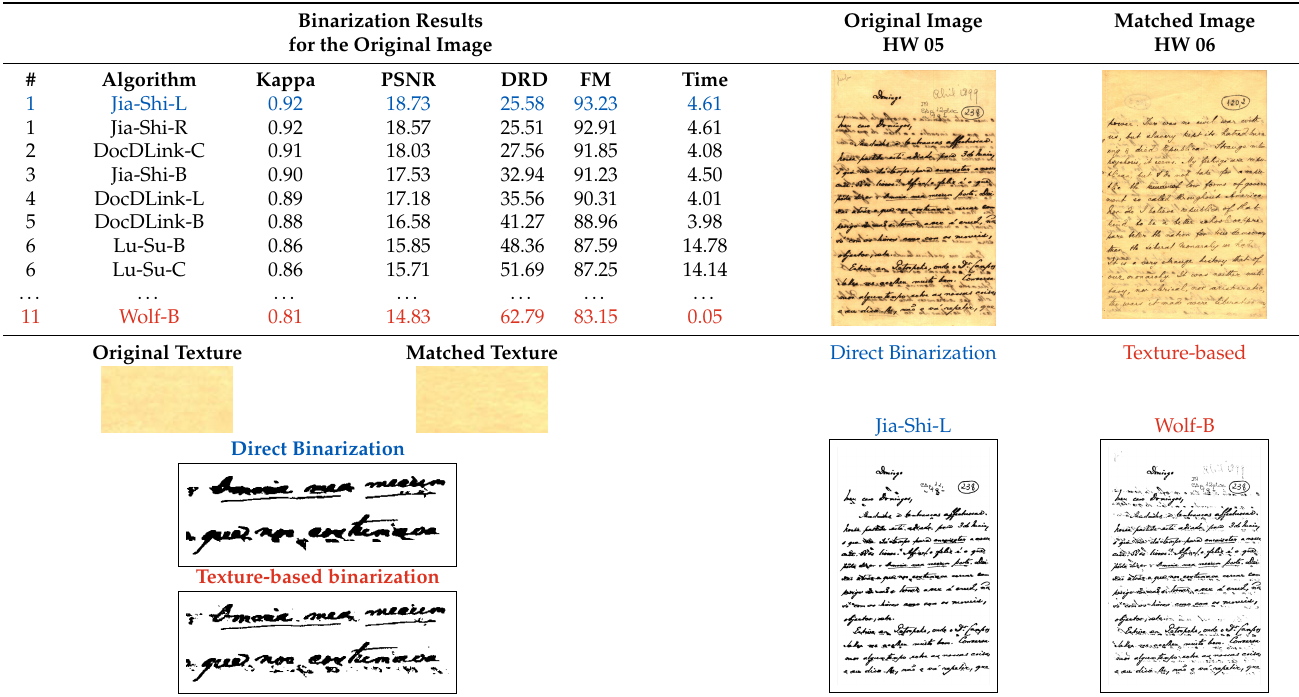
Table 8. Results for image matching with image HW 05.